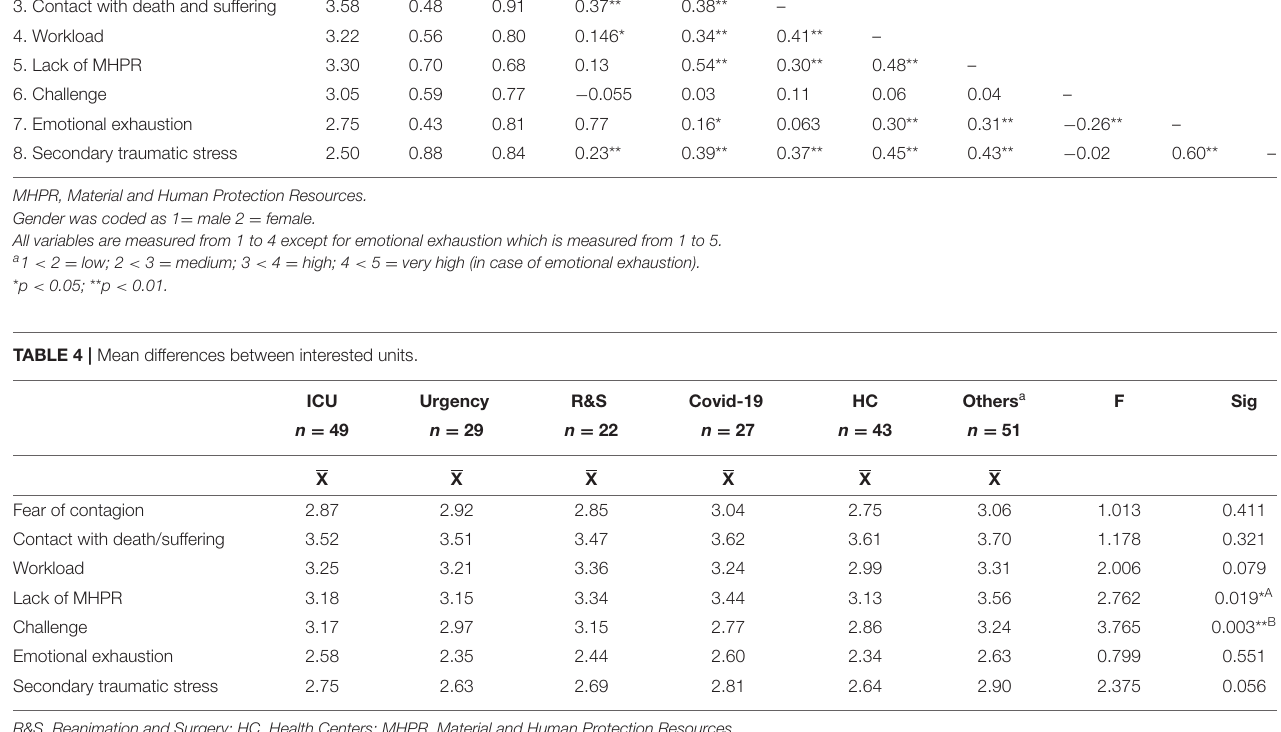
TABLE 3 | Means, standard deviations, internal consistency indexes (Cronbach’s alpha), and bivariate correlations. Variable X a SD